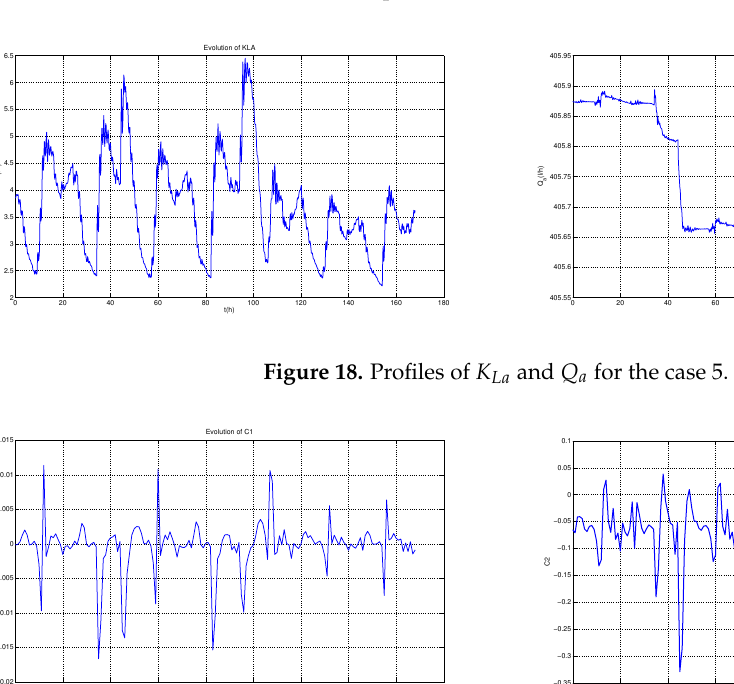
Figure 17. Responses of S O 2 and S NO for the case 5.